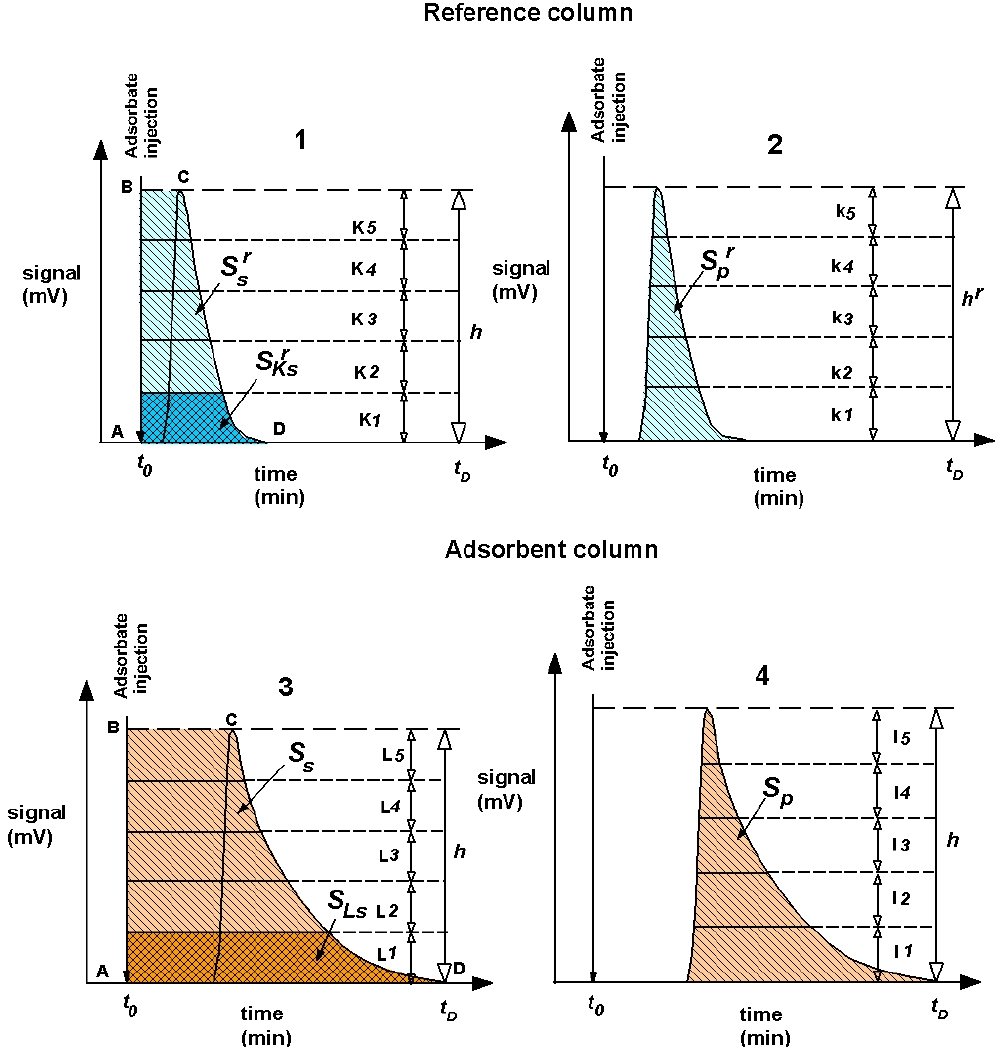
Figure 1. The illustration of applying the peak division method to calculate the value for drawing the isotherm.